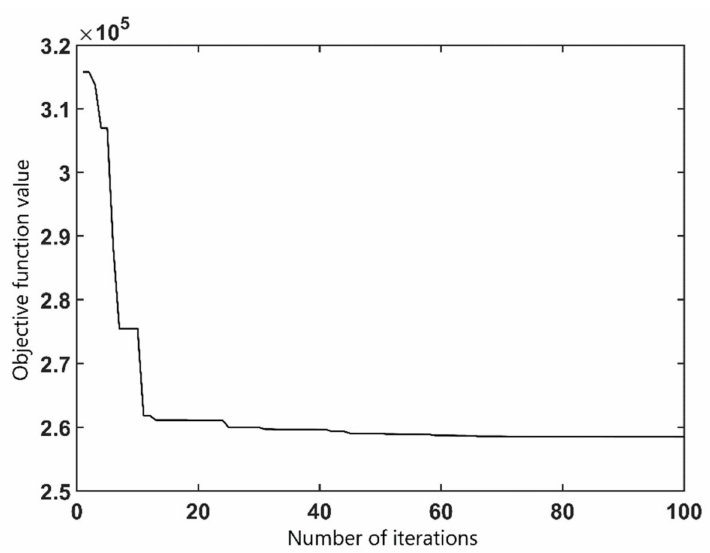
Figure 9. Evolution curve of the objective function